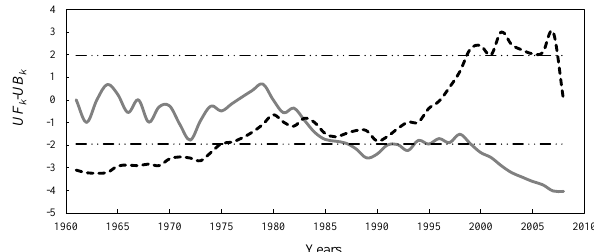
Figure 5. The sequential Mann–Kendall test for annual streamflow in the Miyun Reservoir catchment with forward-trend UF k (solid line) and backward-trend UB k (dotted line). Dashed bold horizontal lines represent critical values at the 95% confidence level.